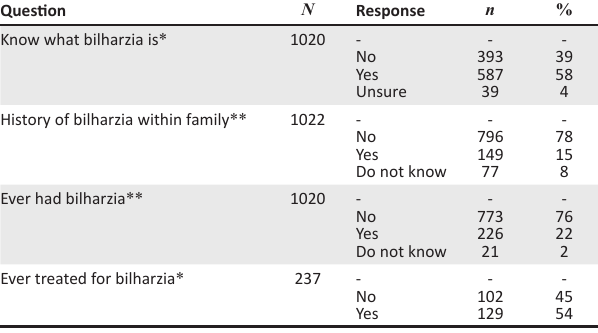
TABLE 5: Pupils’ knowledge and reported history of Schistosoma haematobium (bilharzia). Question N Response